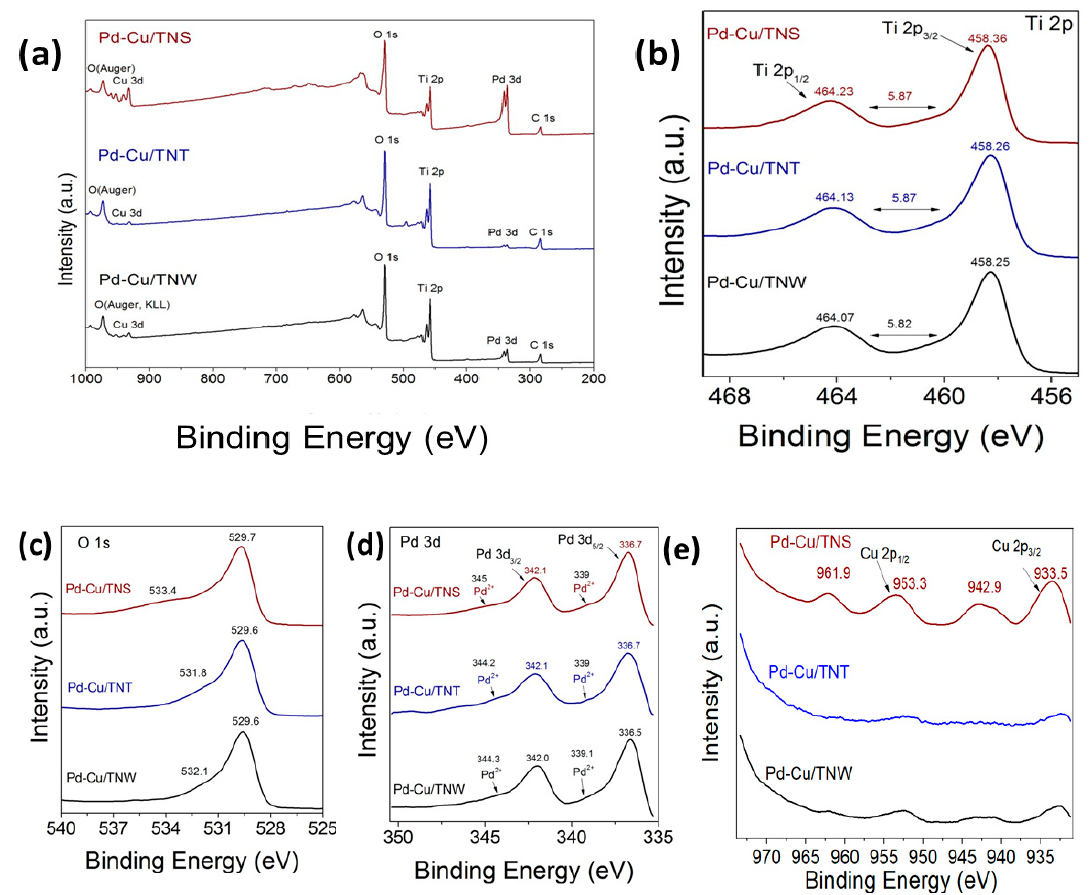
Figure 4. ( a ) Survey XPS spectra obtained over the Pd-Cu/TNS, Pd-Cu/TNT, and Pd-Cu/TNW catalysts; high-resolution XPS spectra over Pd-Cu/TNS, Pd-Cu/TNT, and Pd-Cu/TNW catalysts; ( b ) Ti 2p; ( c ) O 1s, ( d ) Pd 3d, and ( e ) Cu 2p core level spectra.